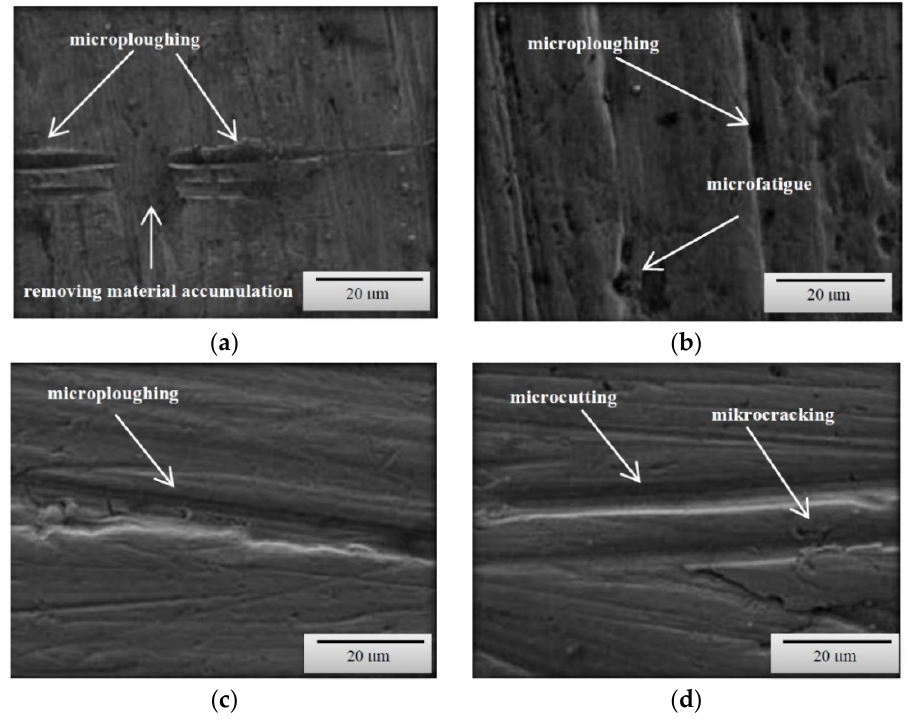
Figure 5. SEM micrographs of the surfaces of tested steels subjected to wear in a heavy soil ( a ) B 27 steel, magnification 1500×; ( b ) Hardox 500 steel, magnification 1500×; ( c ) XAR 600 steel, magnification 1500×; ( d ) TBL Plus steel, magnification 1500×.